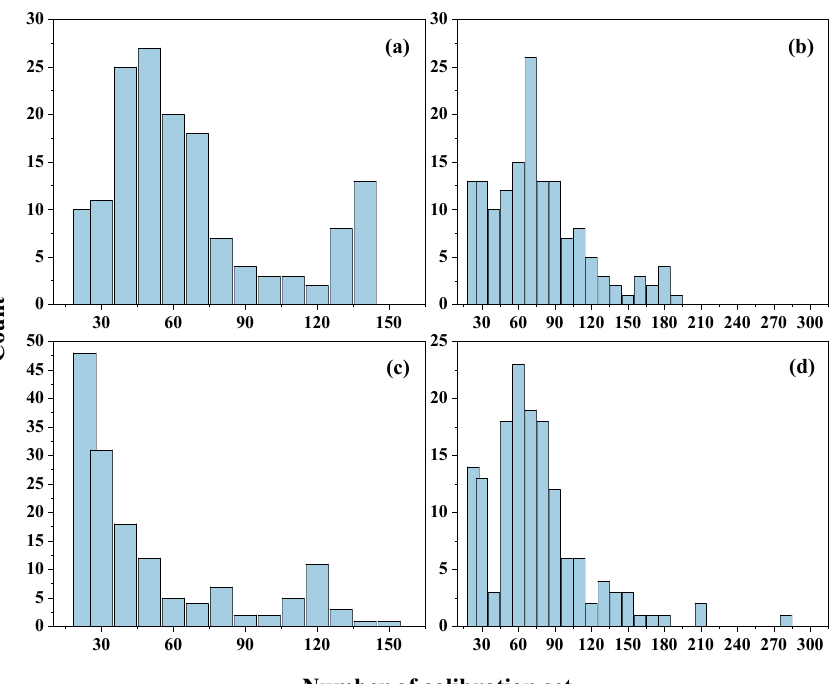
Figure 6. The statistics for the calibration set numbers of each unknown soil sample using the SAM–PLSR method: ( a ) unknown sample from top soil and calibration samples selected from top soil (0–20 cm) samples dataset; ( b ) unknown sample from top soil (0–20 cm) and calibration samples selected from 0–40 cm dataset; ( c ) unknown sample from subsoil (20–40 cm) and calibration samples selected from 20–40 cm dataset; ( d ) unknown sample from subsoil (20–40 cm) and calibration samples selected from 0–40 cm dataset.